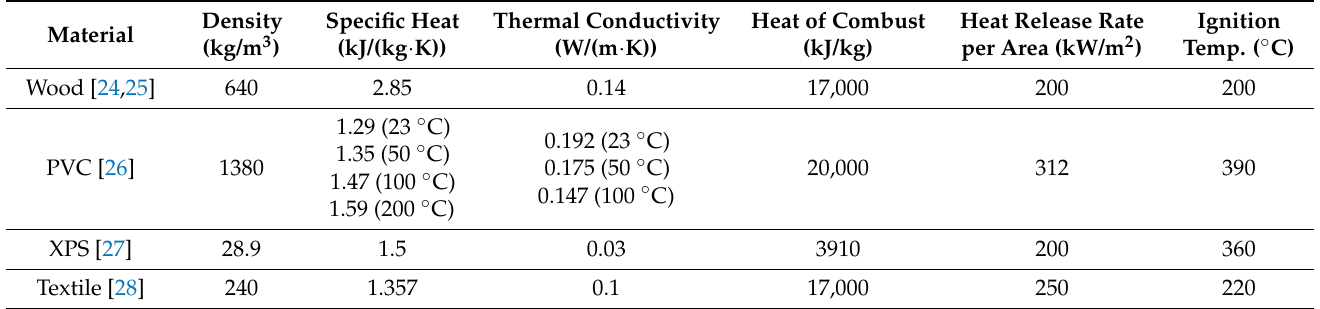
Table 1. Physical and thermal properties of main materials involved in